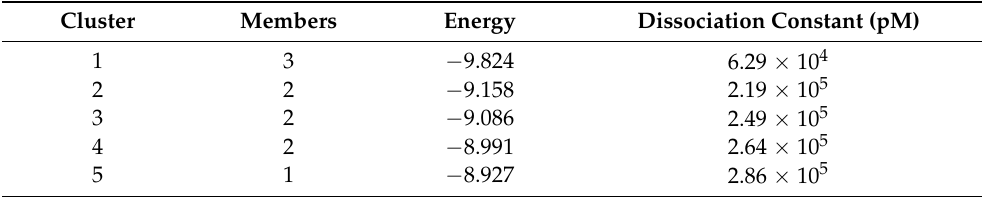
Table 5. Cluster analysis of the docking position